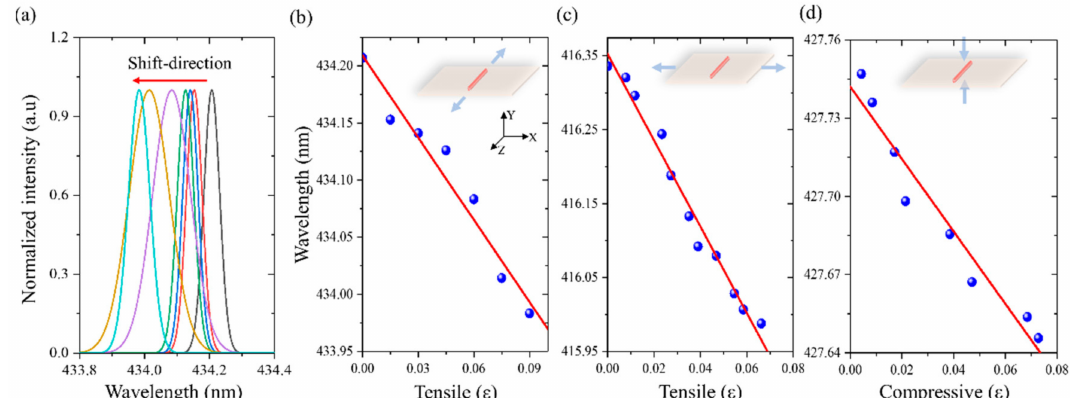
Figure 5. ( a ) PL spectra in the Z direction measured under different stretching conditions from 0 to 0.09 ε . ( b – d ) show the measured lasing wavelength changing under various tensile conditions in the Z and X directions and compressive conditions in the Y direction, respectively. The insets in ( b – d ) show the direction of applied force.